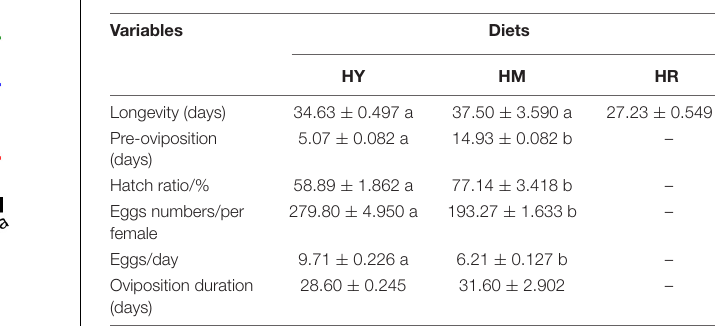
TABLE 2 | Reproductive parameters and longevity (days) (mean ± standard error of the mean) of H. axyridis (Pallas, 1773) feeding with three different diets: (1)